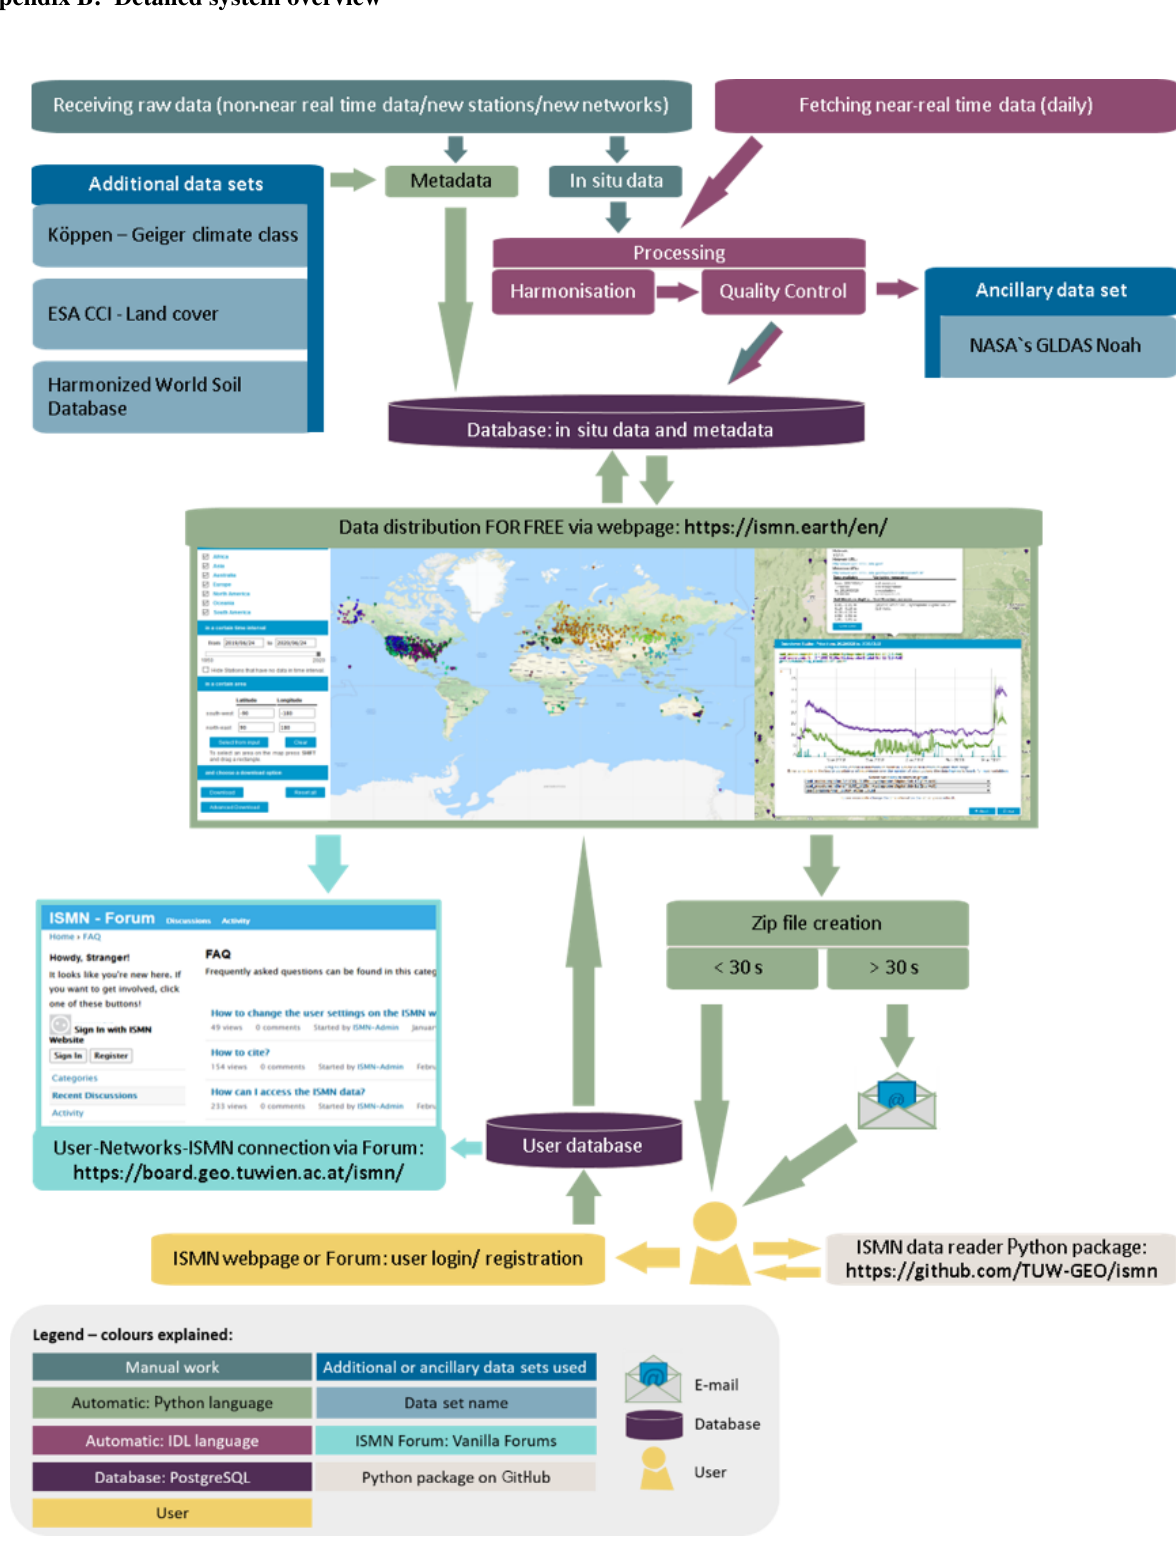
Figure B1. Detailed system overview of the ISMN (status in July